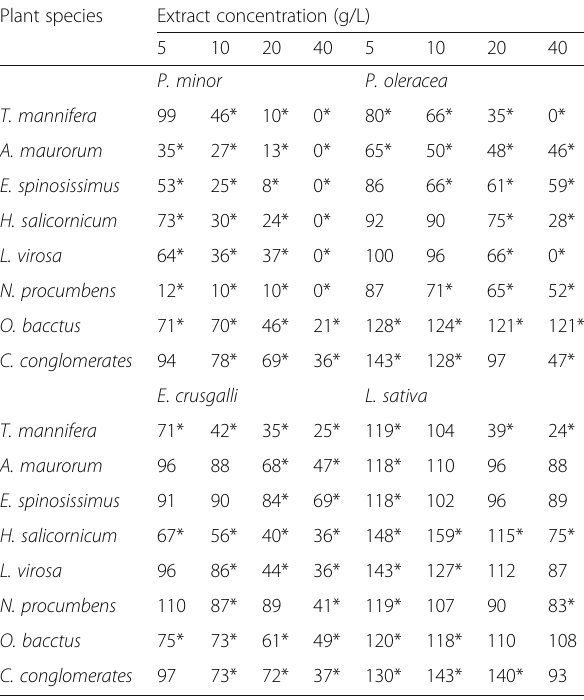
Table 2 Effect of plant extracts (% of control) on shoot length of P . minor , P . oleracea , E crusgalli , and L. sativa